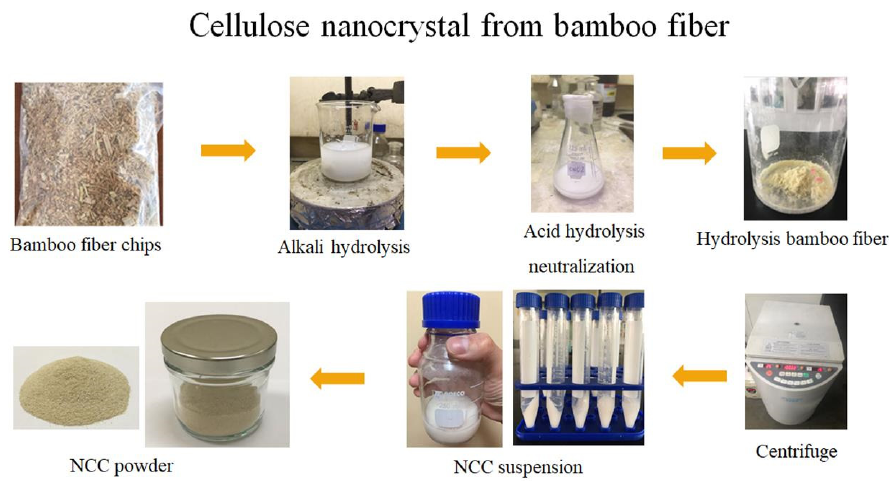
Figure 1. Process of nanoparticle crystal preparation from bamboo.